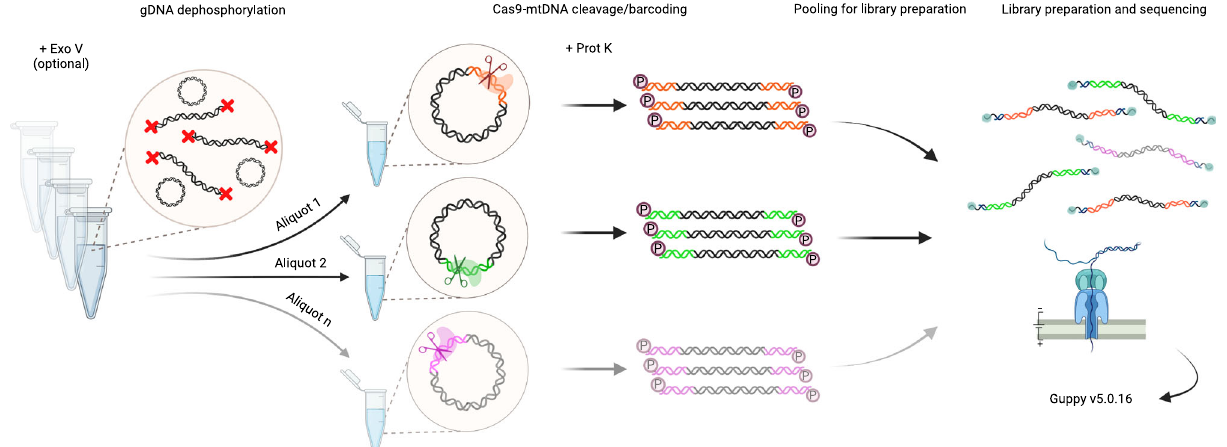
Fig. 1 | Cas9-mtDNA-enrichment, barcoding, pooling and demultiplexing approach for long-read sequencing. A schematic overview of full-length mtDNA targetingwithselecteddual-guideCas9cut-sites.AfteroptionaltreatmentofgDNA withExonucleaseV(ExoV)anddephosphorylation,eachsampleissplitintotwoor morealiquotsfordual-guidetargetedcleavage.Eachcut-siteservesdownstreamas